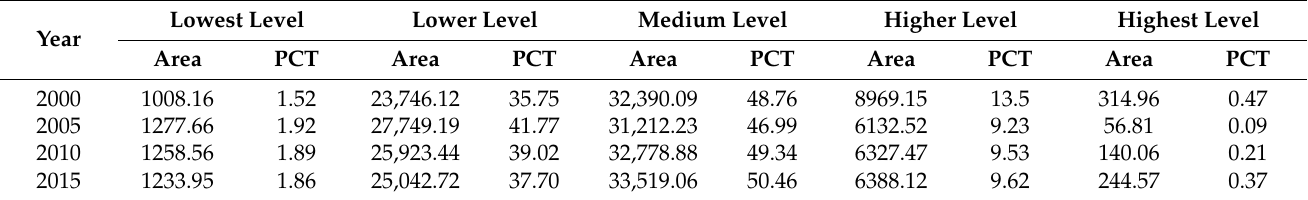
Table 4. Area and proportion of each landscape ecological risk level in Ningxia from 2000 to 2015 (unit:km 2